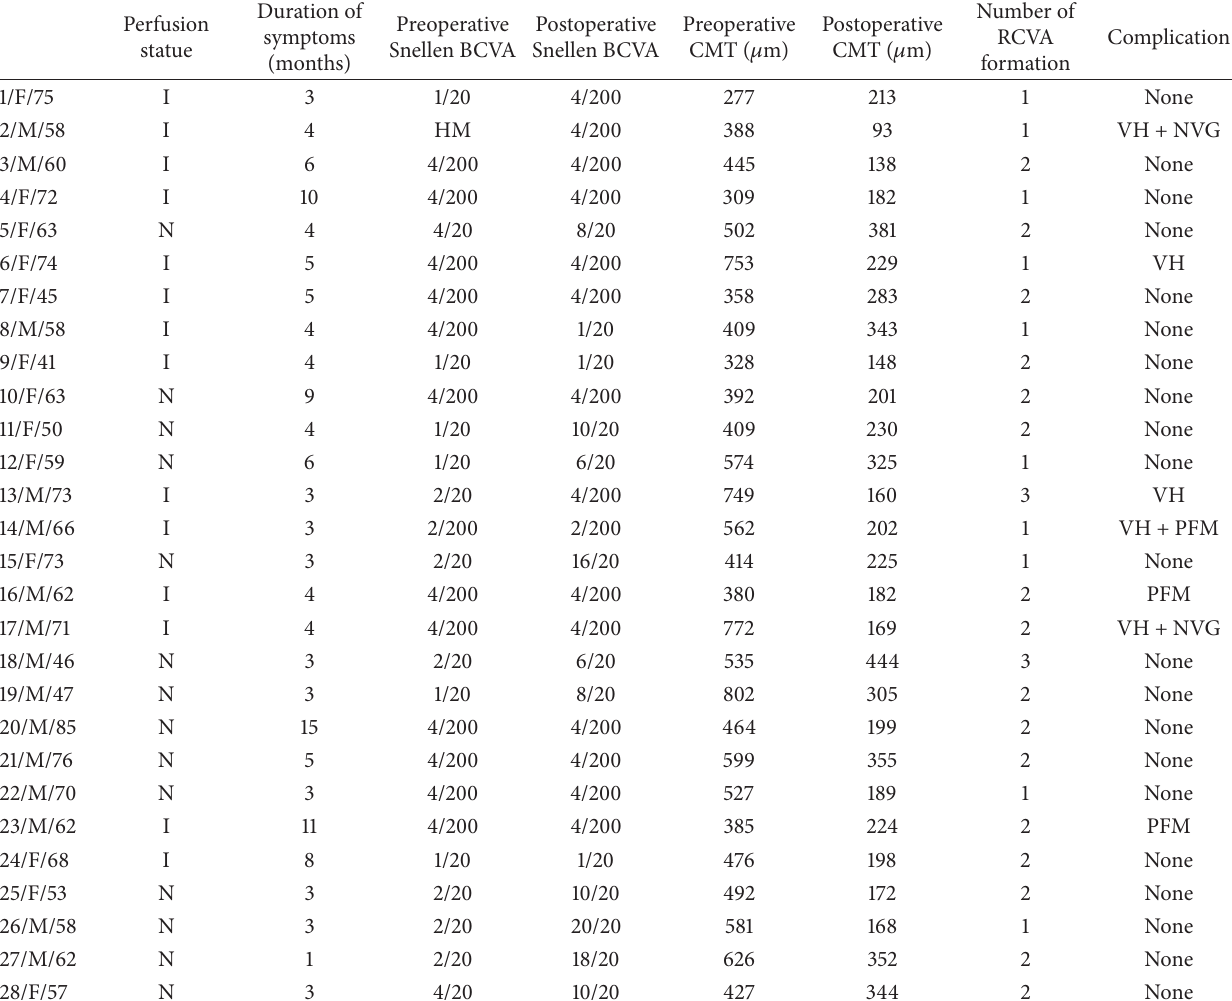
Table 1: Demographic data of